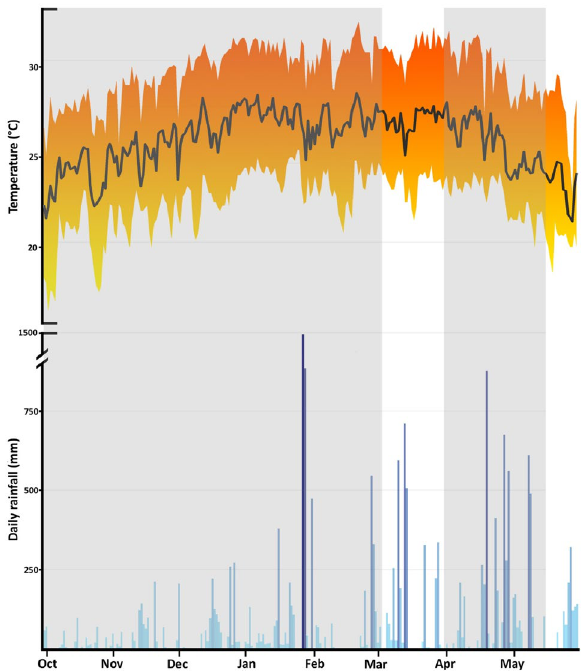
Figure 1. Average daily temperatures and rainfall during the study period (October 2018–May 2019). The grey areas indicate the periods of radio-tracking of the Asian common toad population in Toamasina (Madagascar). Hourly weather data were obtained from the local meteorological station located at Toamasina